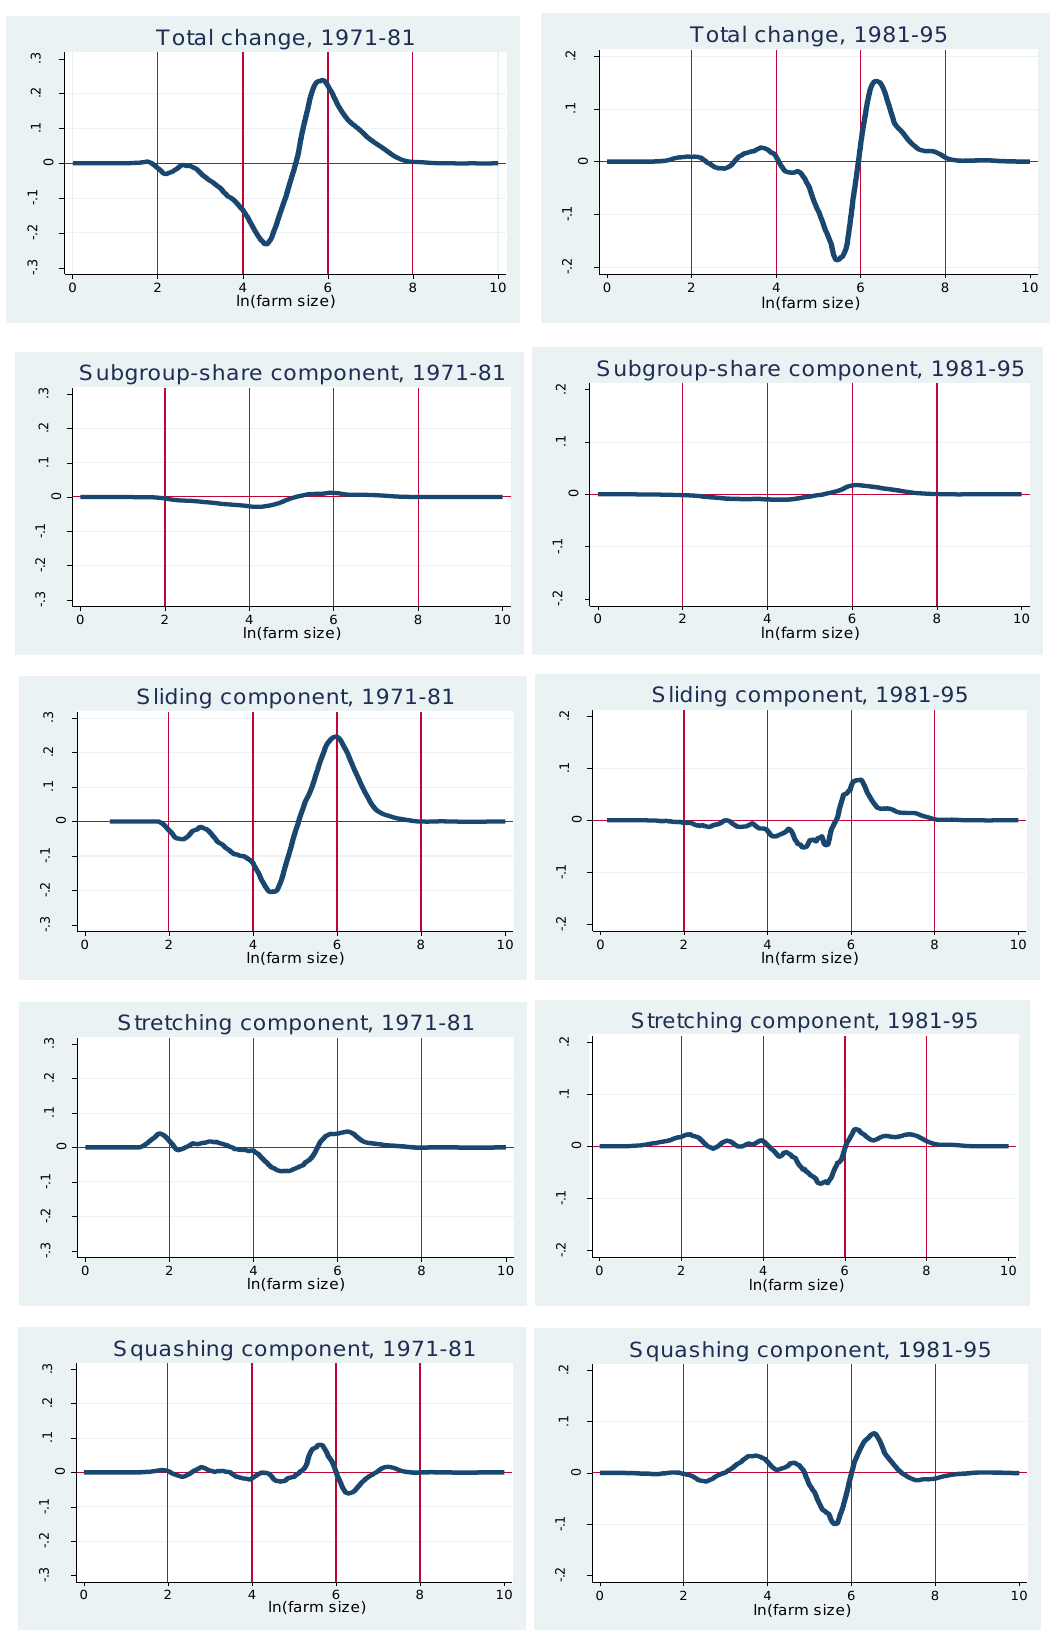
Figure 4. Decomposition of changes in farm size distribution, 1971 to 1981 and 1981 to 1995.